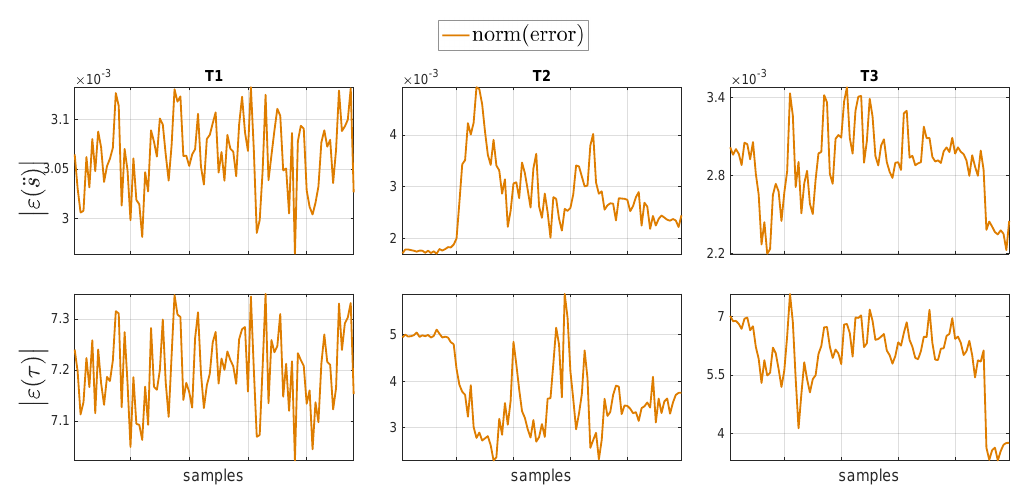
Figure 13. Norm of the error of the overall set of joint accelerations ε ( ¨ s ) [ rad/s 2 ] and torques ε ( τ ) [ Nm] between the estimation with the fixed-base and the floating-base MAP, for tasks T1, T2 and T3.